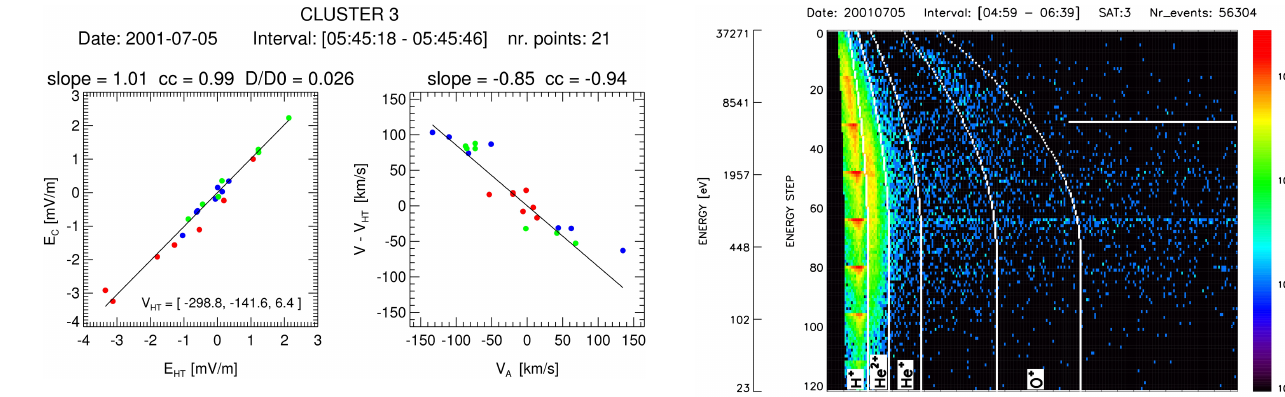
Figure 5. HT frame determination and Walén relation test for the 5 July 2001 crossing, with the same layout as Fig. 3.